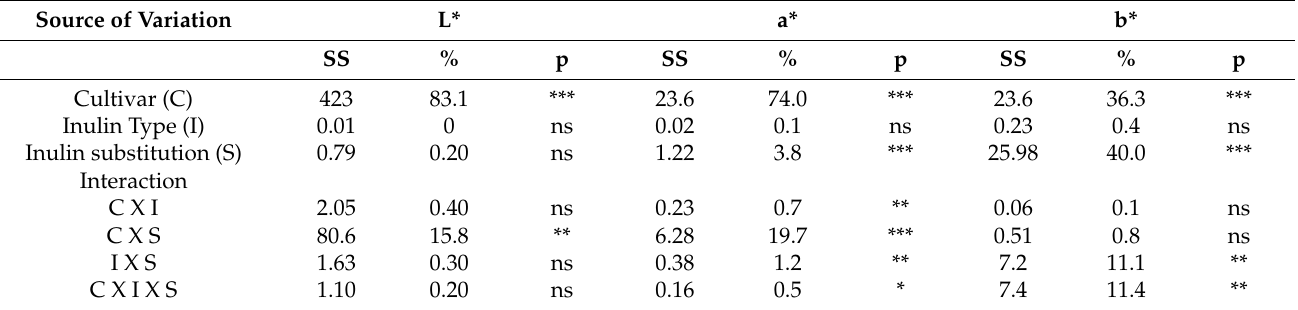
Table 1. Sum of square (SS) and percentage of variation (%) of spaghetti samples color indices (L*, a*, and b*) in relation to the studied factors.